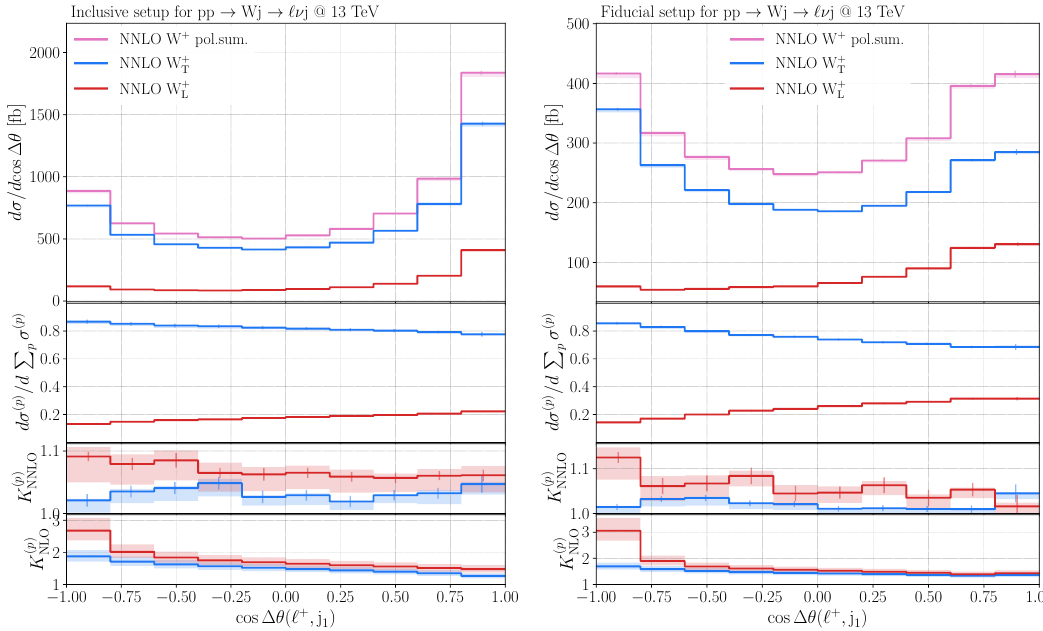
) in the inclusive (left) and fiducial 1